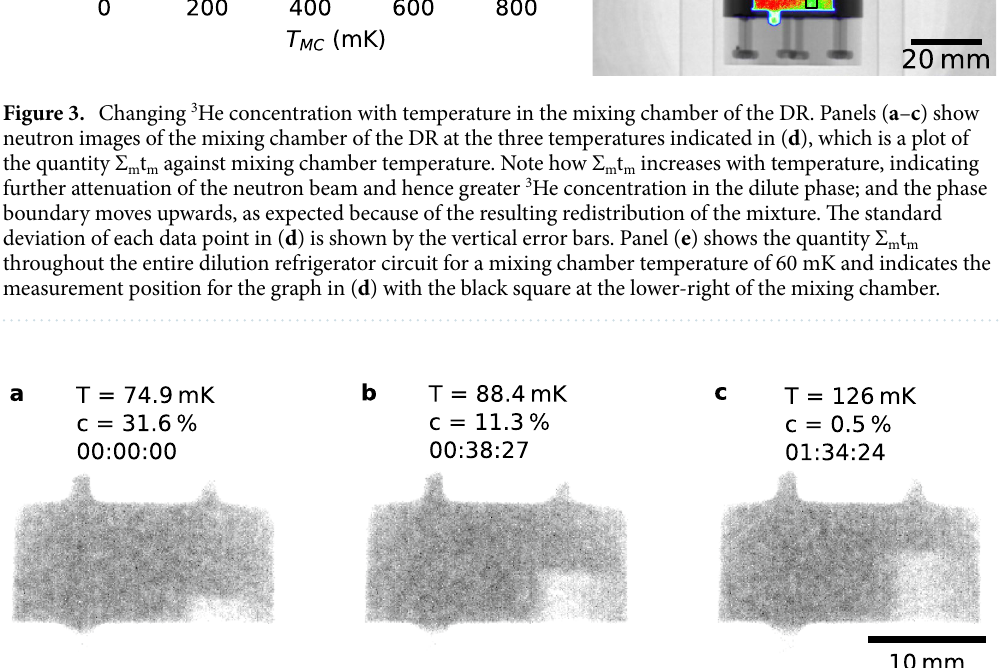
Figure 4. Mixing chamber of the DR during a single-shot operation. Panel ( a ) shows the initial position of the phase boundary before starting to remove the 3 He from circulation, panel ( b ) shows the condition when the 3 He concentration has dropped to 11%, and panel ( c ) is with almost all the 3 He removed. A video of the single-shot process is in Supplementary Video S2. In all three panels, an annotation of the mixing chamber temperature (T), the 3 He concentration ( c ) and the time since beginning the single shot (HH:MM:SS) is